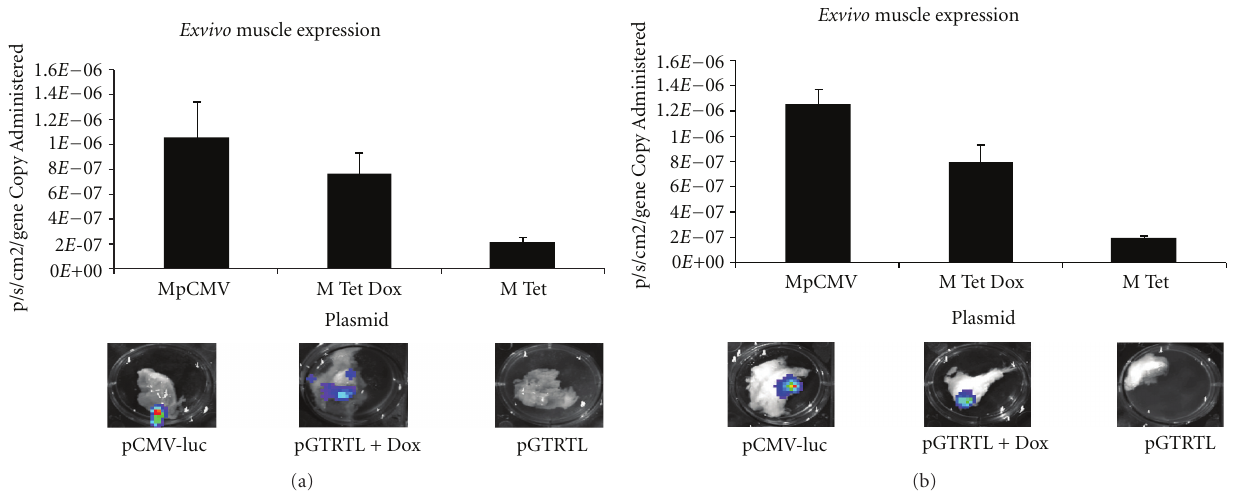
Figure 6: Human musculoskeletal tissue electrotransfected ex vivo with either pCMV-luc or pGTRTL. Expression was observed in all samples. Levels of expression for the “tet-on” plasmid were significantly increased in the presence of